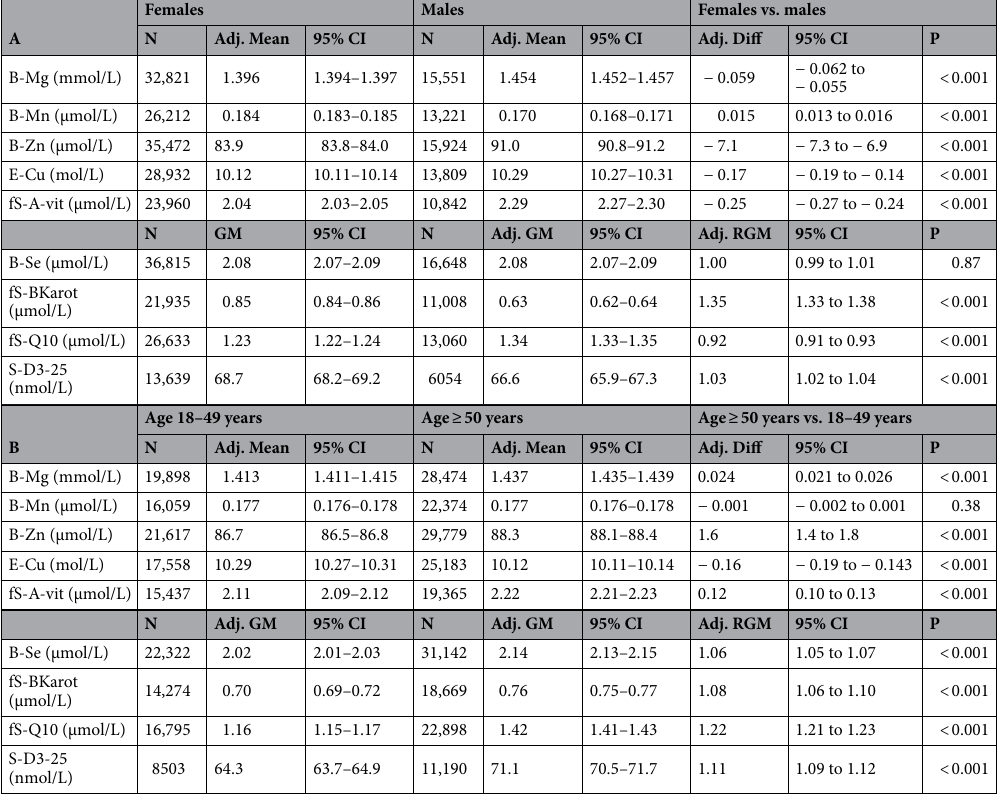
Table 3. Adjusted means (95% CI) for micronutrients in adults (age ≥ 18 years) measured between 1987 and 2020 (A: Females vs. males B: Age ≥ 50 years vs. 18–49 years). Adjustment was based on the general linear model, where age group (≥ 50 years vs. 18–49 years), gender, and 5-year time periods were included as categorical covariates. B-Se, fS-BKarot, fS-Q10 and S-D3-25 were logarithmically transformed before analysis. GM geometric mean, RGM ratio of geometric